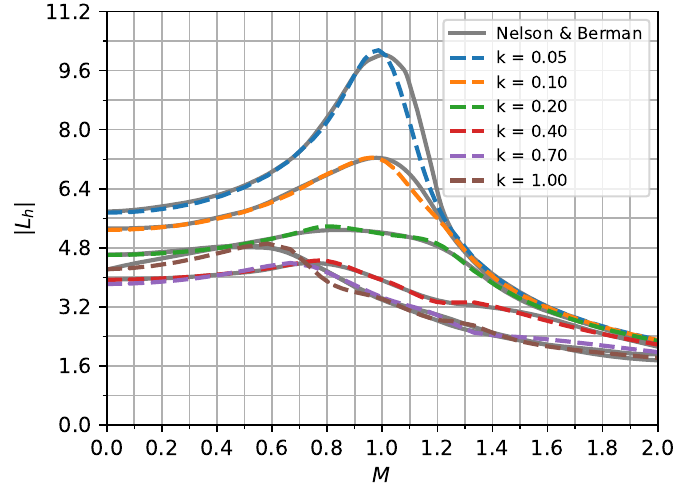
Figure 2. Lift coefficient as a function of Mach number and reduced frequency.